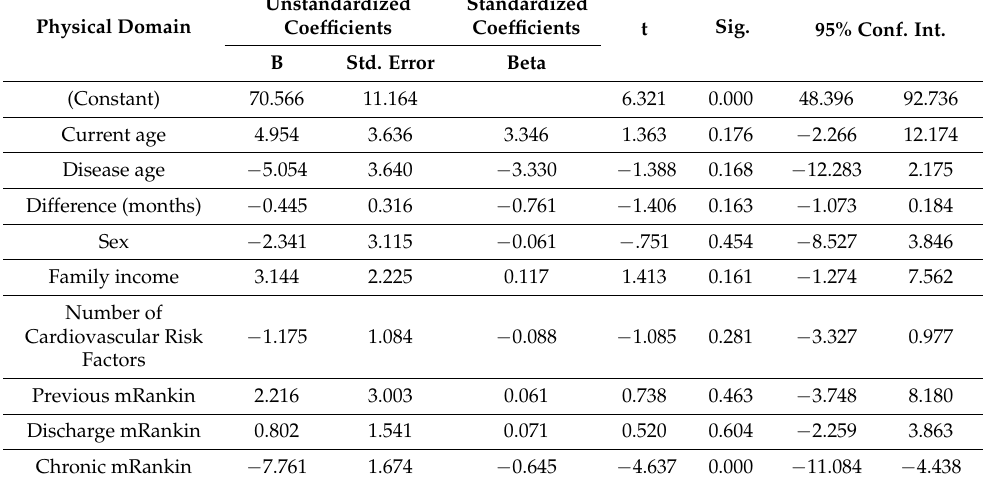
Table 5. Multivariate analysis for Physical